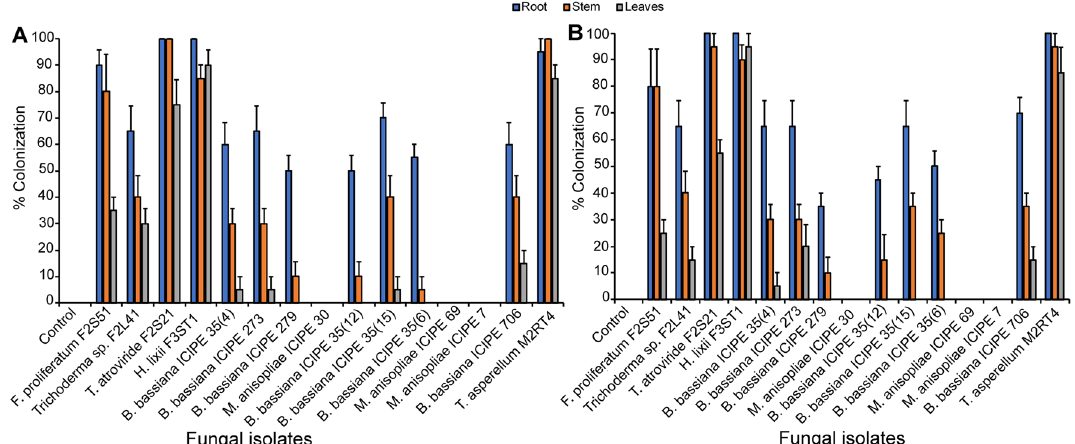
Figure 1. Endophytic colonization of tomato Solanum lycopersicum ( A ) and nightshade Solanum scabrum ( B ) host plant parts by 15 fungal isolates at 4–5 weeks post-inoculation. Bar chart represents means ± SE (standard error) at 95% CI ( P < 0.05; n =